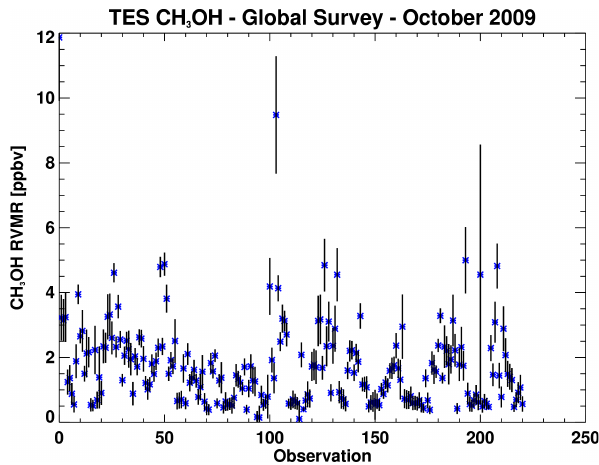
Fig. 9. Signal-to-noise ratio (SNR) and degrees of freedom for sig- nal (DOFS) in the TES methanol observations. Left panel: RVMR values as a function of the SNR for a Global Survey from October 2009. Right panel: DOFS as a function of SNR for the same Global Survey. Empty circles have SNR < 1.0.